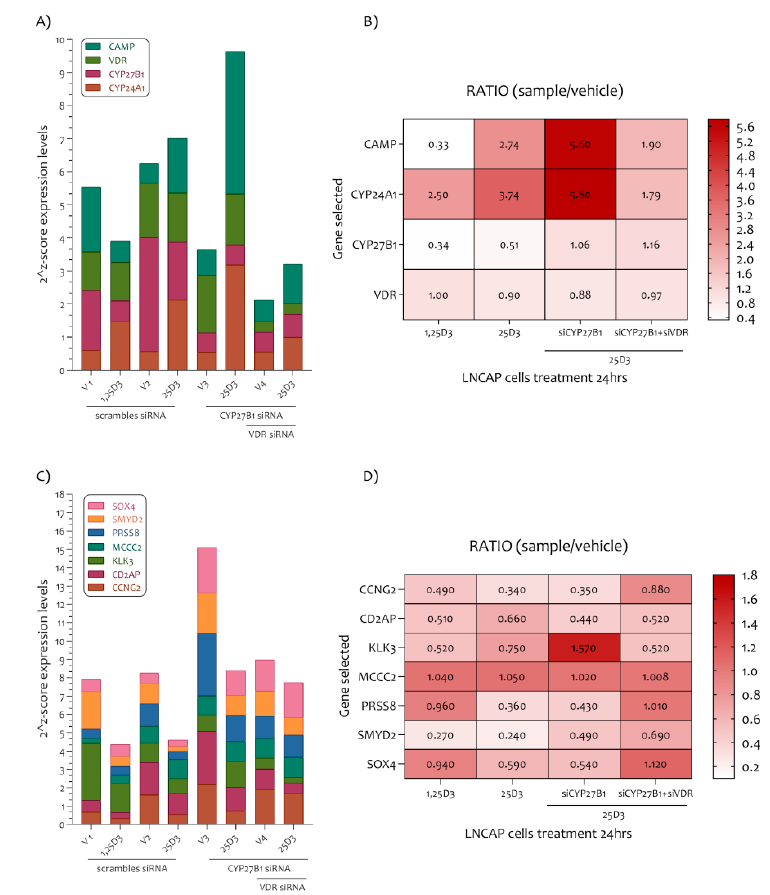
Figure 6. PCa-related genes modulated in the LNCaP cell line under 1,25D 3 and 25D 3 treatment. ( A ) In the LNCaP cell line the 1,25D 3 reduced the expression levels of CYP27B1 and CAMP, and on the contrary increased the expression levels of CYP24A1. An exception were VDR expression levels. ( B ) The CYP24A1 and CAMP expression levels are regulated by 25D 3 in LNCaP cells via